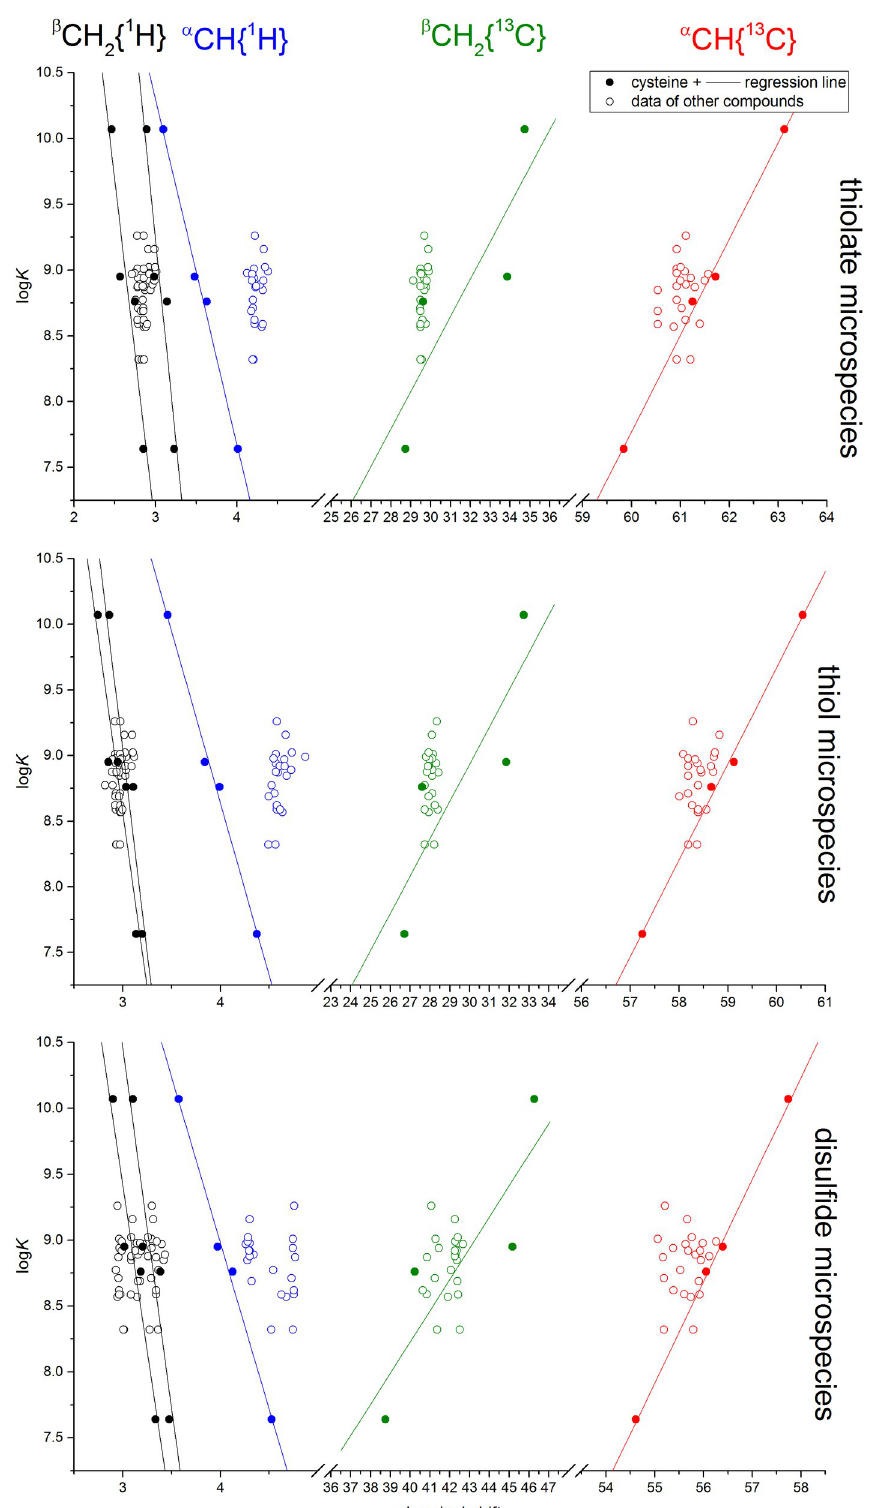
Fig 2. The multivariate linear regression fits of the chemical shift data of cysteine data (solid circles) vs cysteine species-specific thiolate basicities. The chemical shift data of the others (see section 3.2) are superimposed on this regression fit with empty